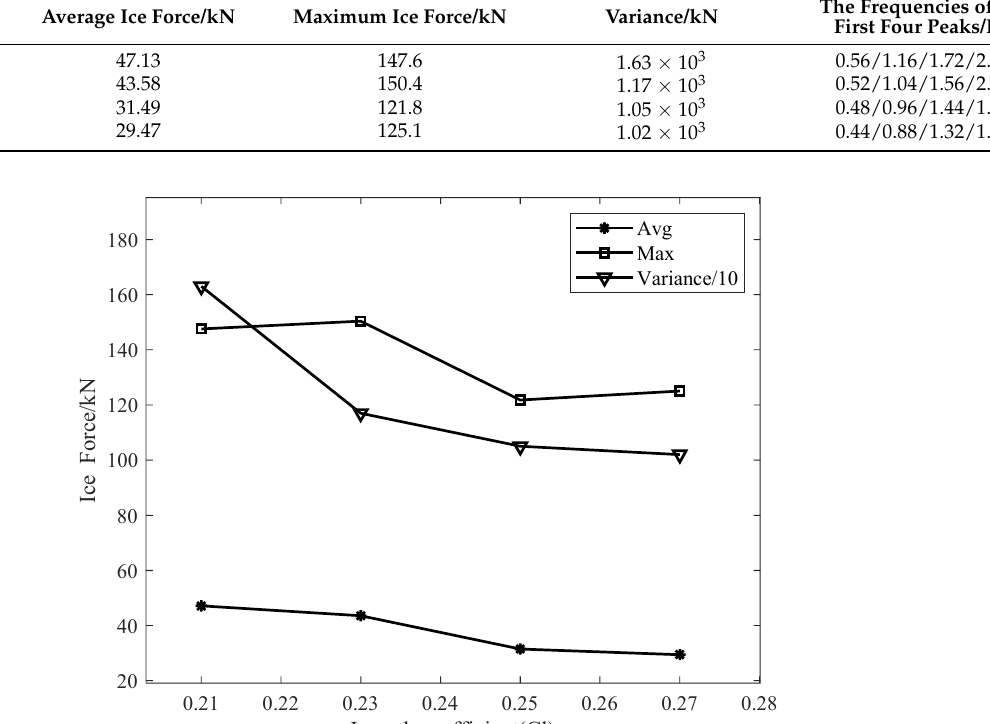
Figure 12. Change trend of variance and ice force with length coefficients ( C l ).